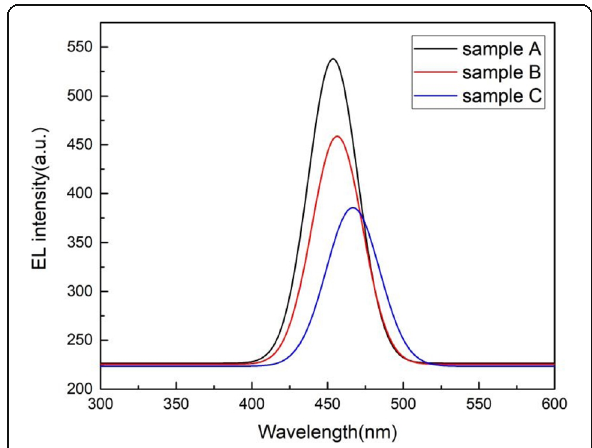
Fig. 2 EL spectra of samples A, B, and C under 5 mA